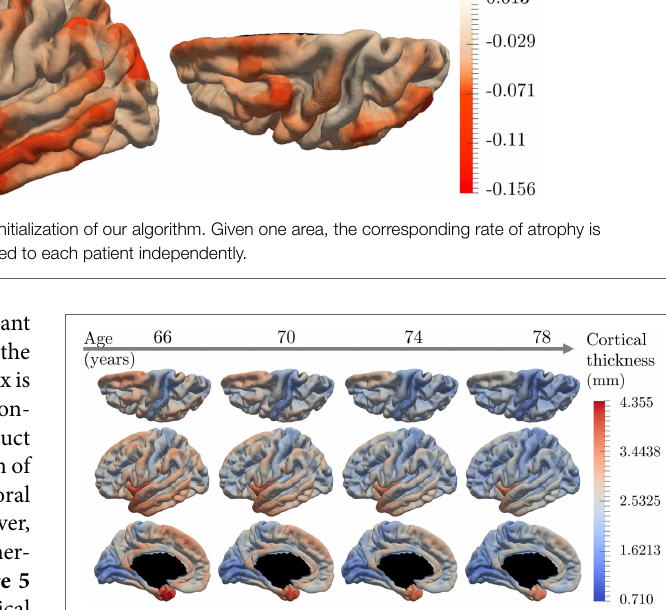
FIGURE 6 | Estimated modes of evolution of the cortical thickness from 66 to 78years old. This typical spatiotemporal pattern of atrophy propagation shows an important cortical loss in the superior frontal lobe, the temporal lobe, and the hippocampus